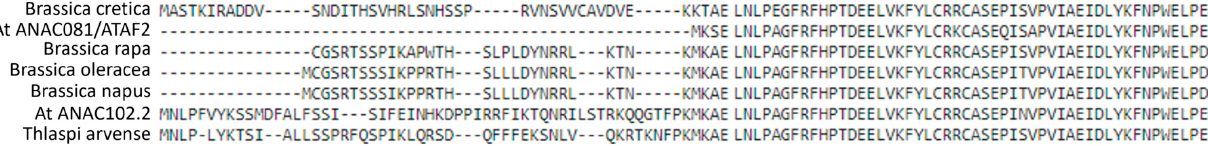
Figure 2. N’-terminus alignment of ANAC102 and ATAF2 putative homologues from several repre- sentatives of the Brassicaceae family.